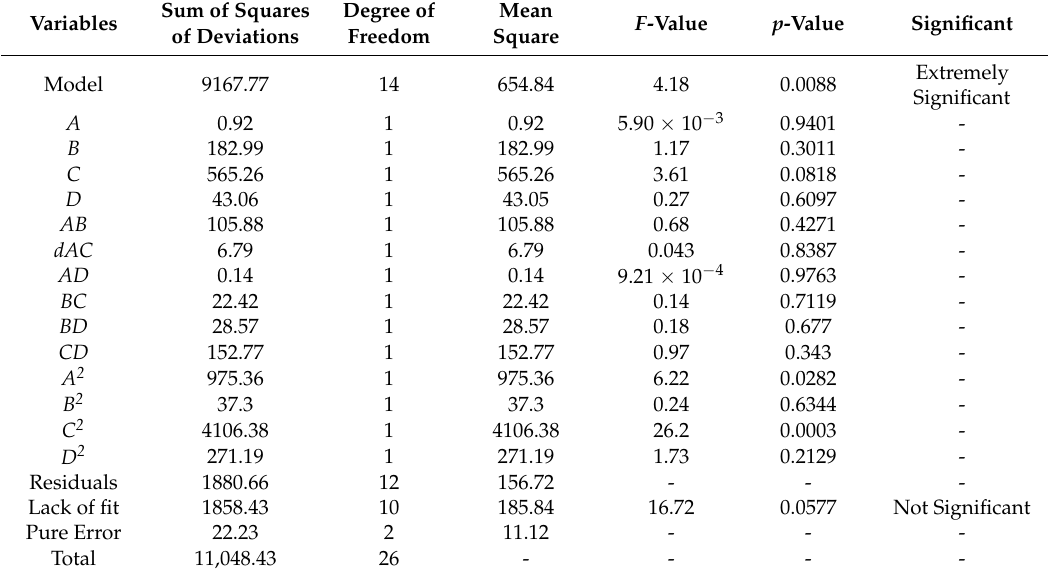
Table 6. Variance analysis results for the tensile strength